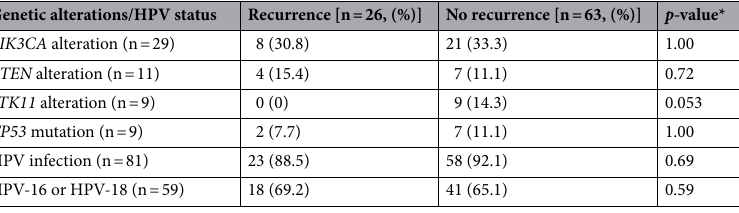
Table 5. Association between recurrence and frequency of genetic alterations or HPV status. HPV human papillomavirus. *Fisher’s exact t-test.